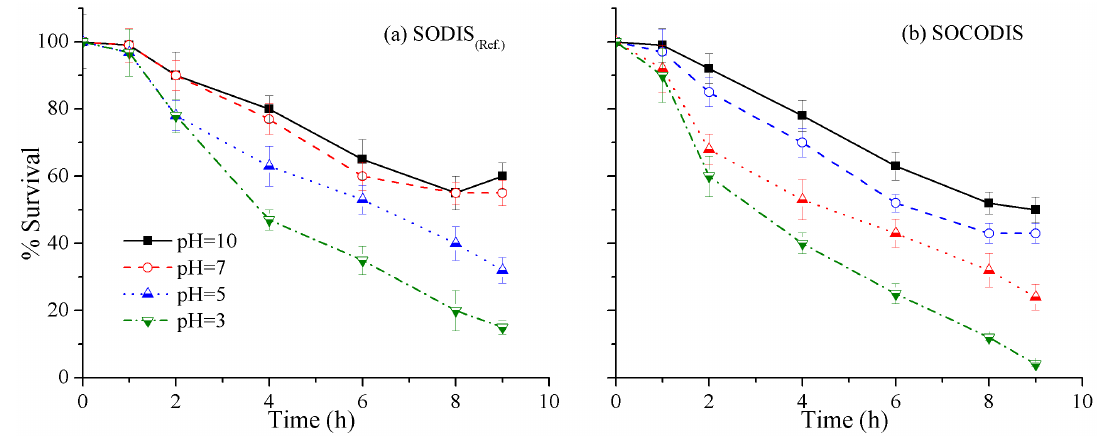
Figure 8. Effects of different initial pH values on P.aeruginosa inactivation in (a) SODIS (Ref.) , and (b) SOCODIS system at weak weather conditions.